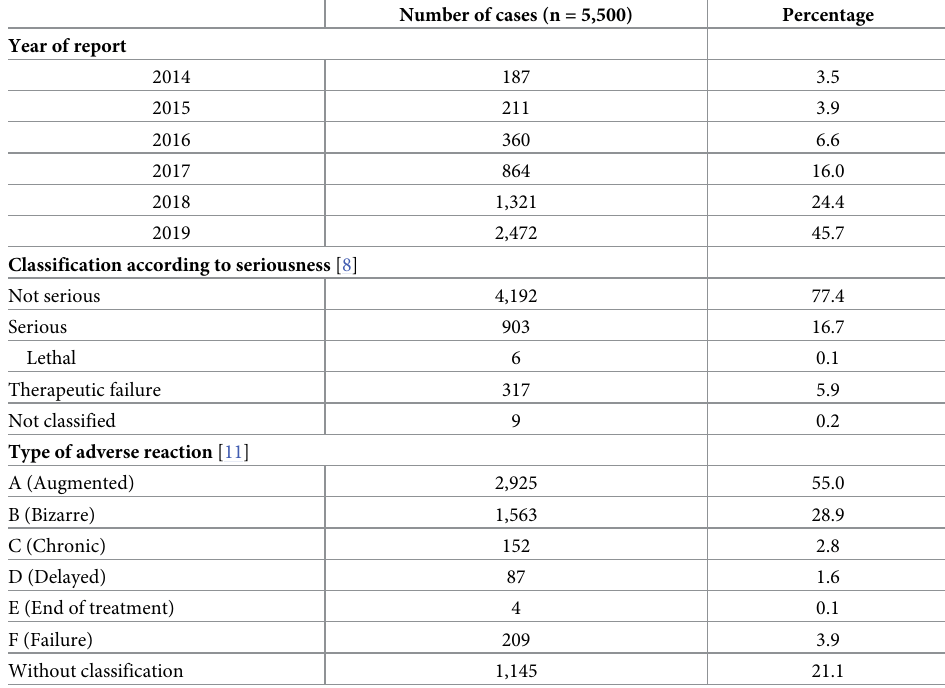
Table 1. Number of reports per year, classification according to seriousness and type of adverse reactions in patients treated with biological agents in Colombia from